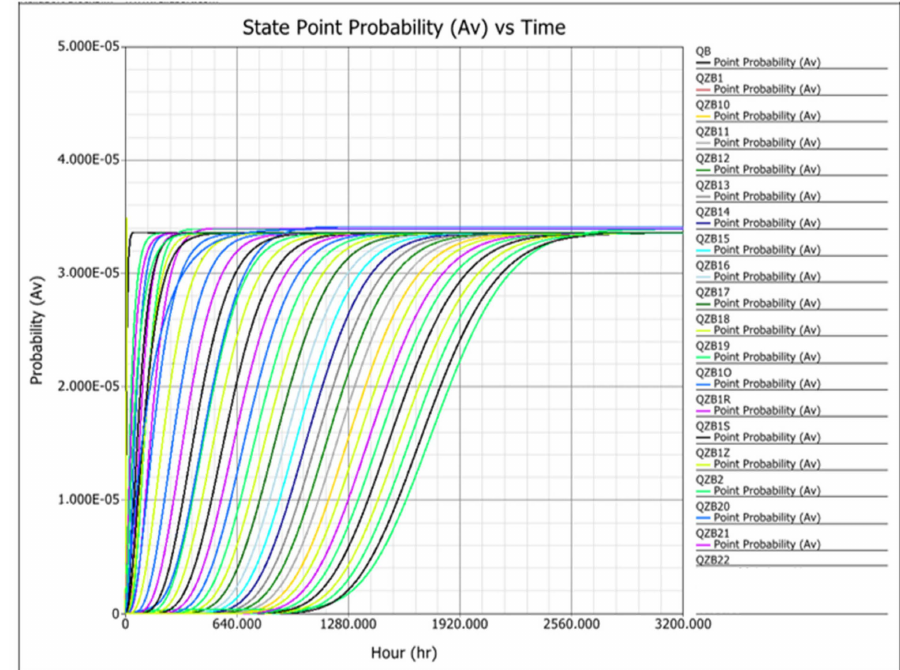
Figure 18. Probability of an FAS staying in distinguished safety hazard states Q ZB (t) in the case of the system in question. Zonal (partial) availability coefficients for separated technical states of a focused FAS Q B ,Q ZB1 ,Q ZB2 ,Q ZB3 , . . . ,Q ZB1r ,Q ZB2r ,Q ZB3r , . . . ,Q ZB1s ,Q ZB2s ,Q ZB3s , . . . ,Q ZB1o , Q ZB1o , i.e., safety unreliability and hazard. The figure does not show state R 0 (t) (for t = 0 R 0 (t) = 1) (study based on computational data from the BlockSim